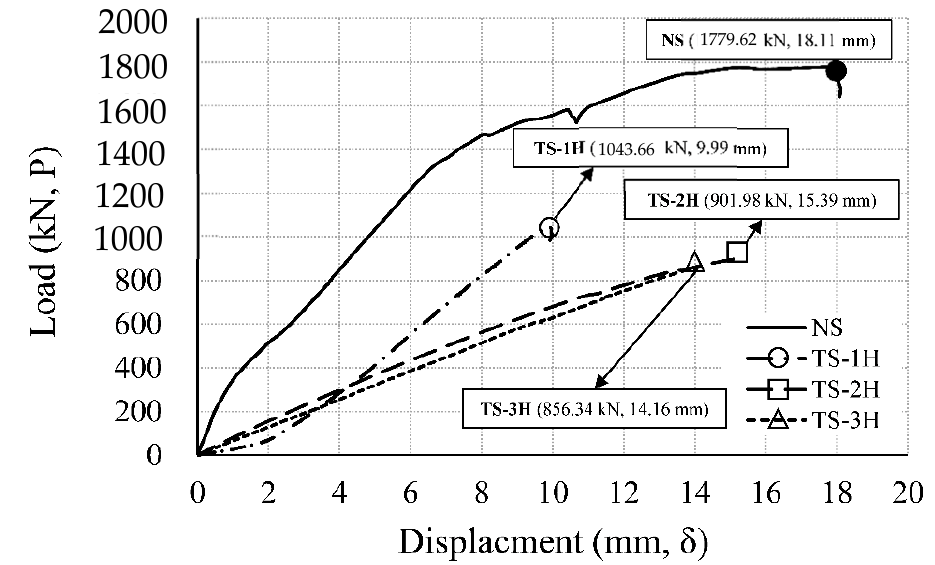
Figure 13. Load–displacement relationship (NS, TS specimen).